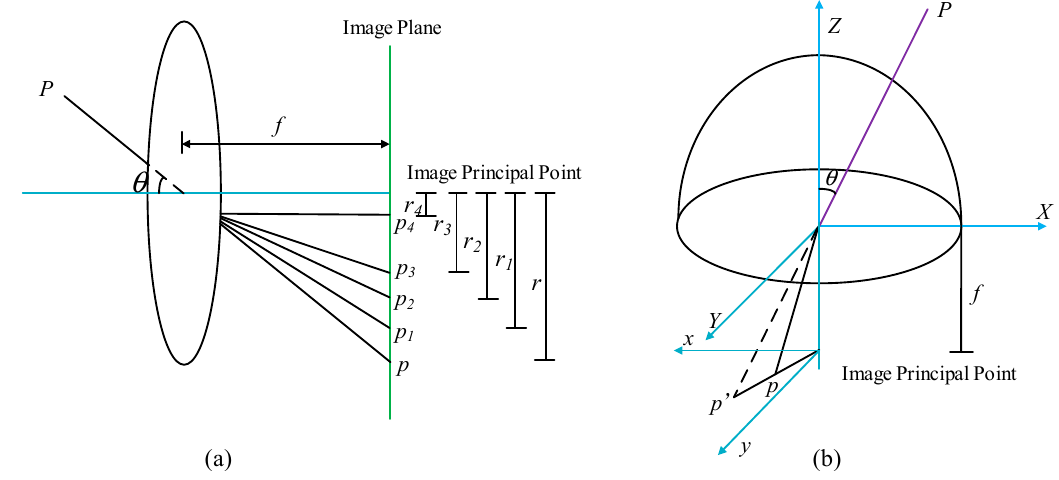
Figure 5. Mapping principles of different lenses. ( a ) The projections of different lens, p, p 1 , p 2 , p 3 and p 4 are perspective imaging, stereographic imaging, equidistance imaging, equisolid angle imaging, and vertical projection; ( b ) difference between a pinhole lens and a fisheye lens. For a fisheye lens, the actual image is the mapping of perspective image on hemisphere surface to image plane.